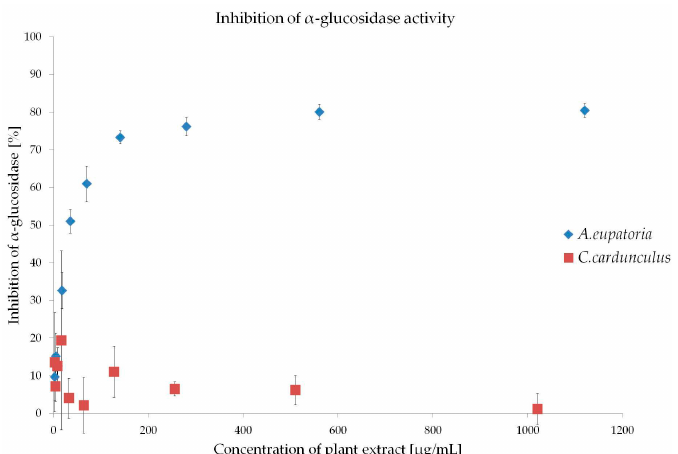
Figure 1. Inhibition of α -glucosidase by A. eupatoria (IC 50 = 46.31 ± 8.76 μ g/mL) and C. cardunculus (IC 50 not achieved) water extracts. Data are shown as mean ± SD and were compared using the one-way ANOVA followed by Tukey-Kramer post-hoc test.